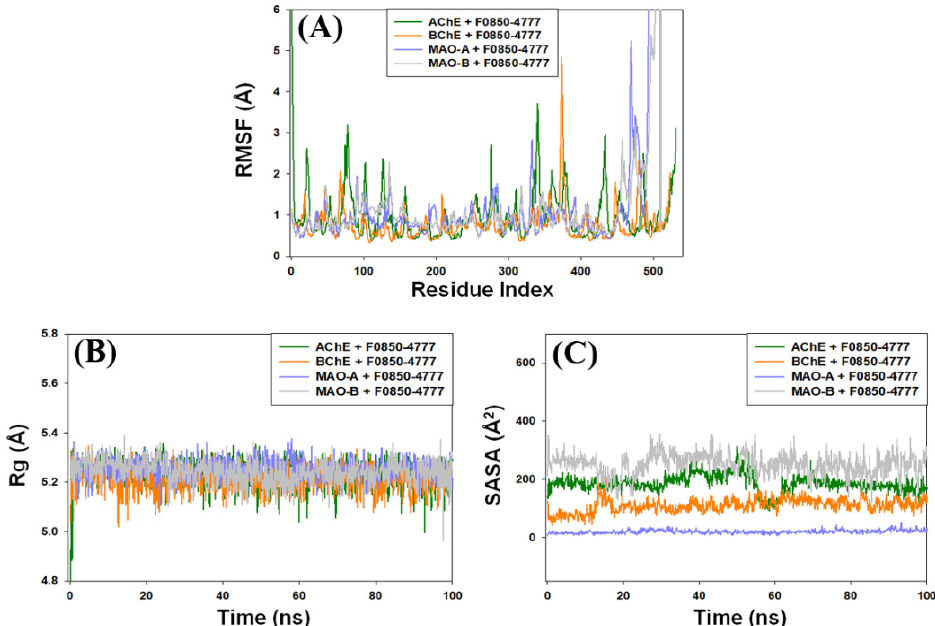
Figure 6. ( A ) Average root mean square fluctuation (RMSF) values of AChE, BChE, MAO-A, and MAO-B in the presence of F0850-4777; ( B ) the variation in Rg of F0850-4777 bound with different proteins (AChE, BChE, MAO-A, and MAO-B); ( C ) SASA of target proteins AChE, BChE, MAO-A, and MAO-B bound to F0850-4777.